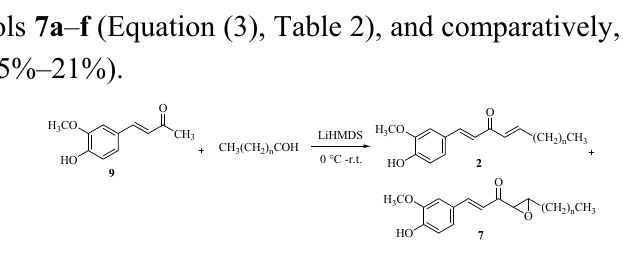
Table 2. Cross aldol condensation under air